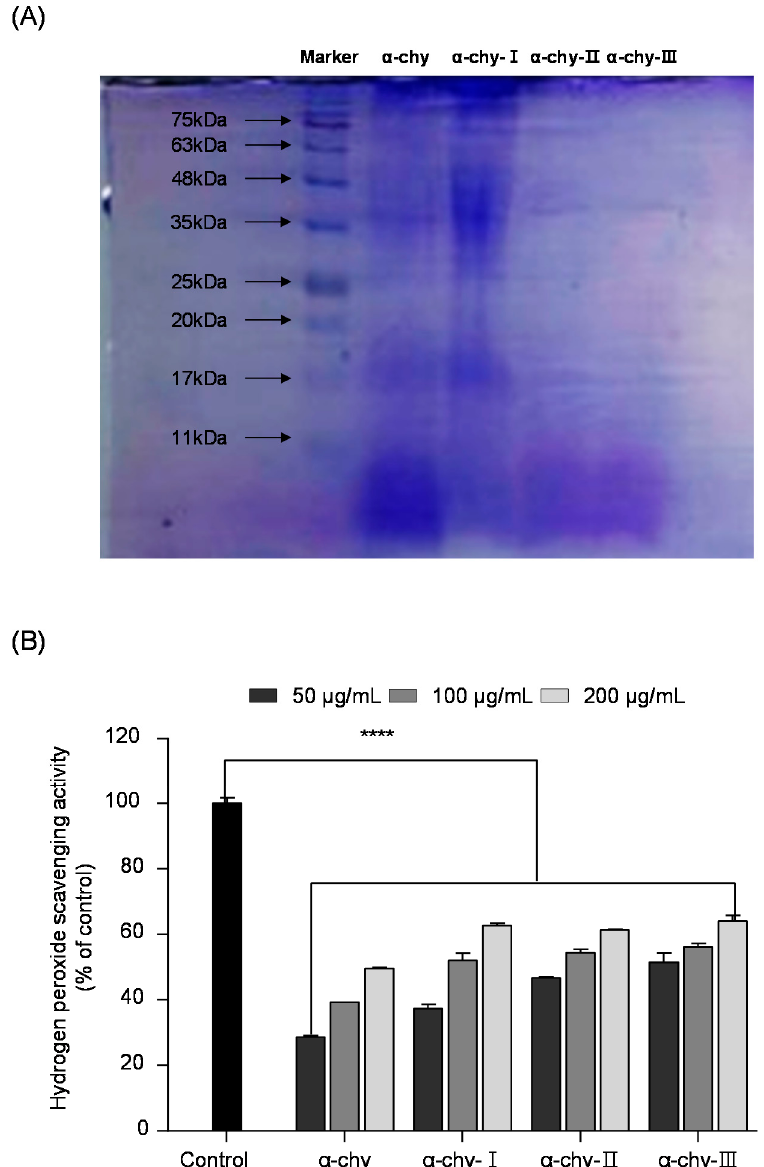
Figure 2. Molecular weight distribution and hydrogen peroxide scavenging activity of α -chy and its UF fractions. Sodium dodecyl sulfate-polyacrylamide gel electrophoresis (SDS-PAGE) pattern ( A ) and hydrogen peroxide scavenging activity of UF fractions ( B ). Experiments were performed in triplicate and data are expressed as mean ± SD; Significant difference identified at **** p < 0.0001 as compared to the control group.